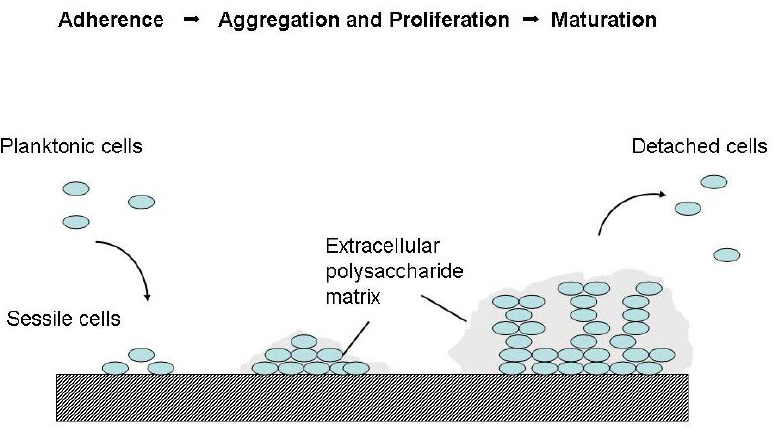
Figure 1. Biofilm formation (reprinted from [20] with permission from Elsevier ®